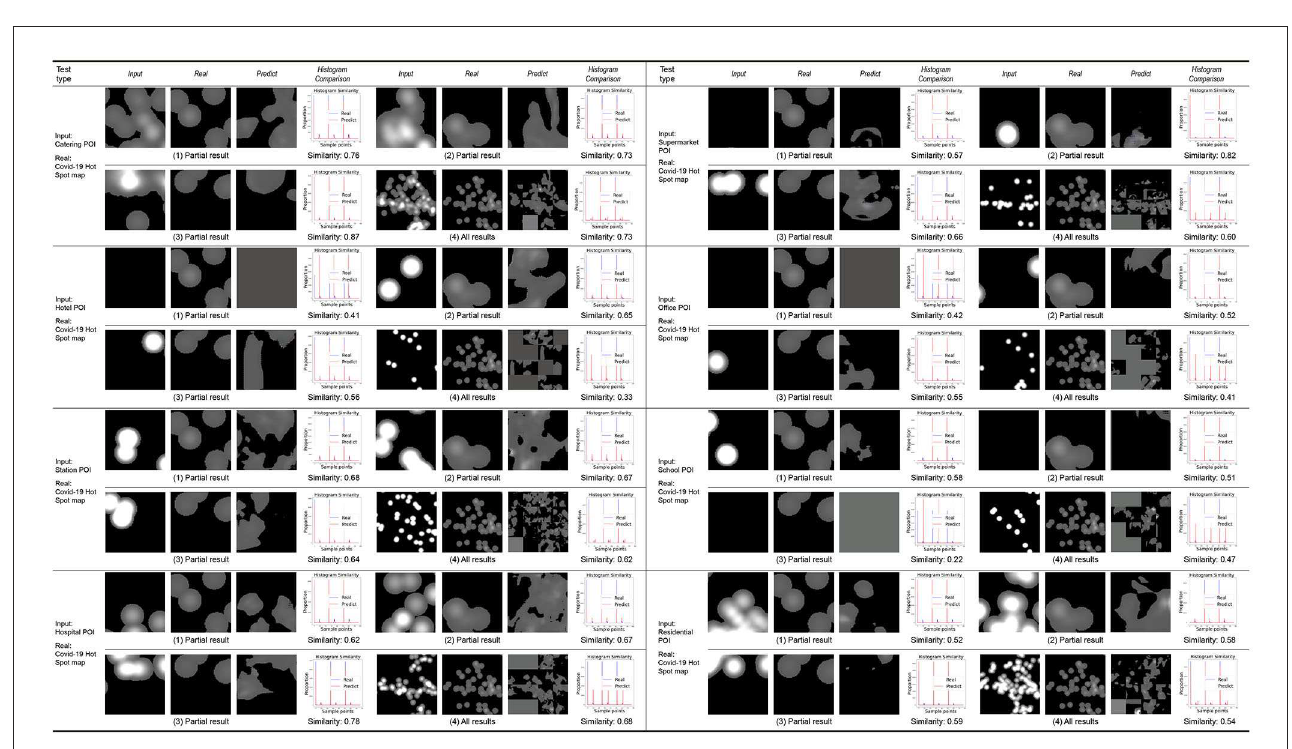
FIGURE9 The heat map prediction results of different types of POIs in Taipa.